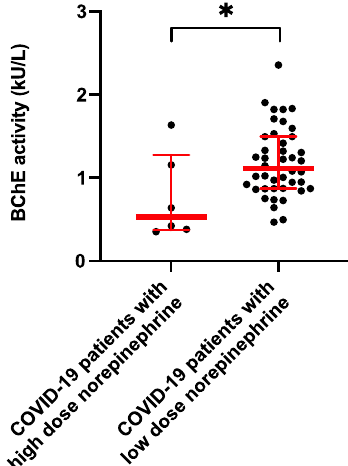
Figure 4. BChE activity reflects level of norepinephrine support on day 7 following ICU. Scatterplots represent the BChE activity in cardiocirculatory compromised COVID-19 patients with need for higher doses of norepinephrine (>0.3 µg/kg/min, n = 6) compared to critically ill COVID-19 patients with low-dose norepinephrine therapy (<0.3 µg/kg/min, n = 42) (BChE activity: 530 U/l (373–1.275) vs. 1.113 U/L (871–1.496)). * p < 0.05 Mann–Whitney U-Test).